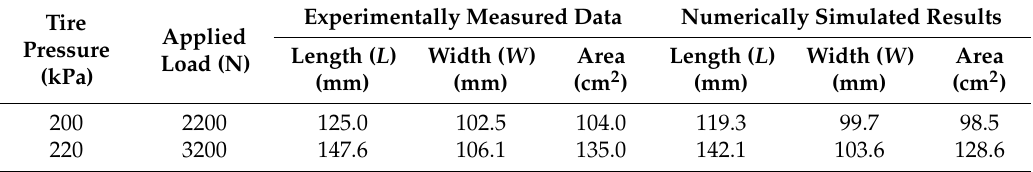
Figure 5. Verification of simulation model against experimental data on tire static test. ( a ) Tire static loaded test. ( b ) Load-tire vertical deformation comparison of numerically simulated results and experiment measurements. Table 4. Contact area comparison of the numerically simulated results and experiment measurements.